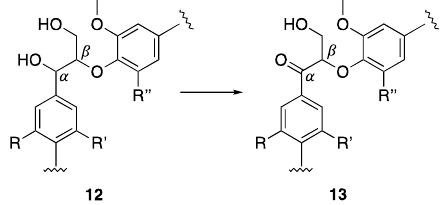
Figure 2. Lignin samples oxidation.